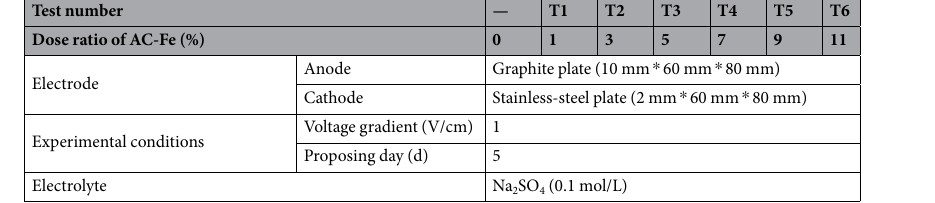
Table 3. Single-factor experimental conditions regarding the dose